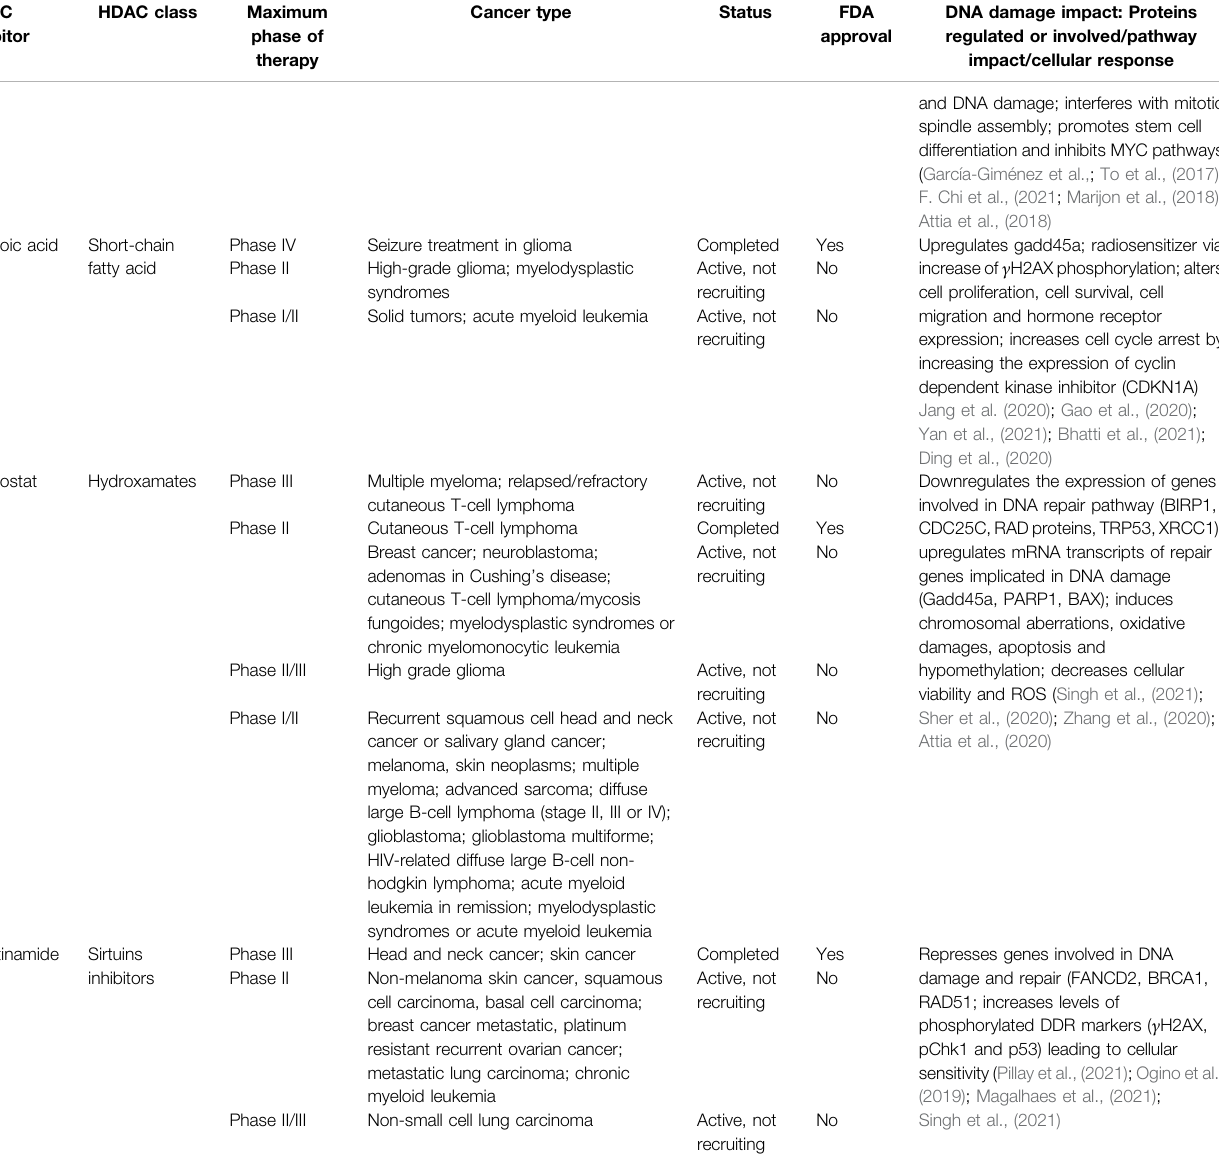
car fi lzomib (proteasome inhibitor) is currently in phase I/II clinical trials for the treatment of patients with relapsed/ oligonucleotide. Nucleoside DNMTis are integrated into the DNA and are prone to toxicity (e.g. 5-azacytidine, azacytosine and zebularine) ( Table 2 ) (Zhou et al., 2002; Stresemann and Frank 2008; Gnyszka et al., 2013). On the other hand, non- nucleoside DNMTis are less toxic and usually more